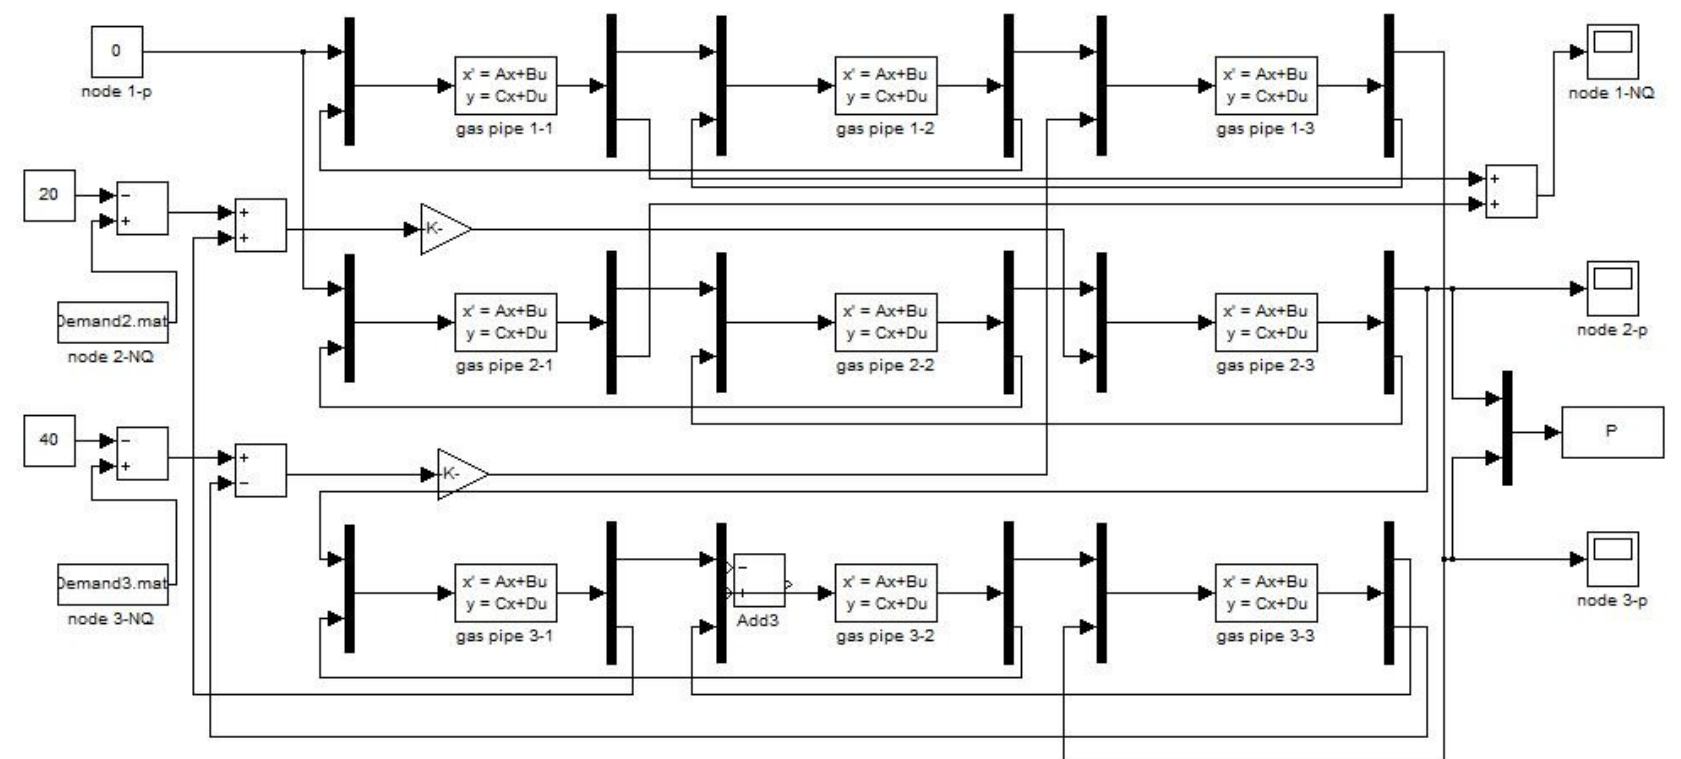
Figure 9. MATLAB-Simulink model of the typical